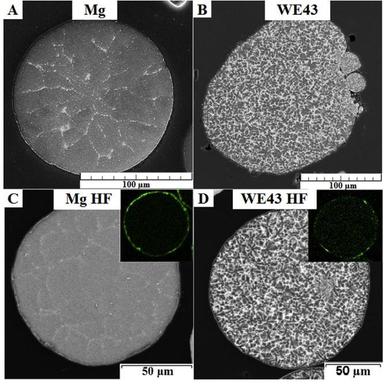
The cut of the A) Mg powder, B) WE43 powder, C) Mg immersed in HF (24h) with EDS map of F, D) WE43 immersed in HF (24h) with EDS map of F.